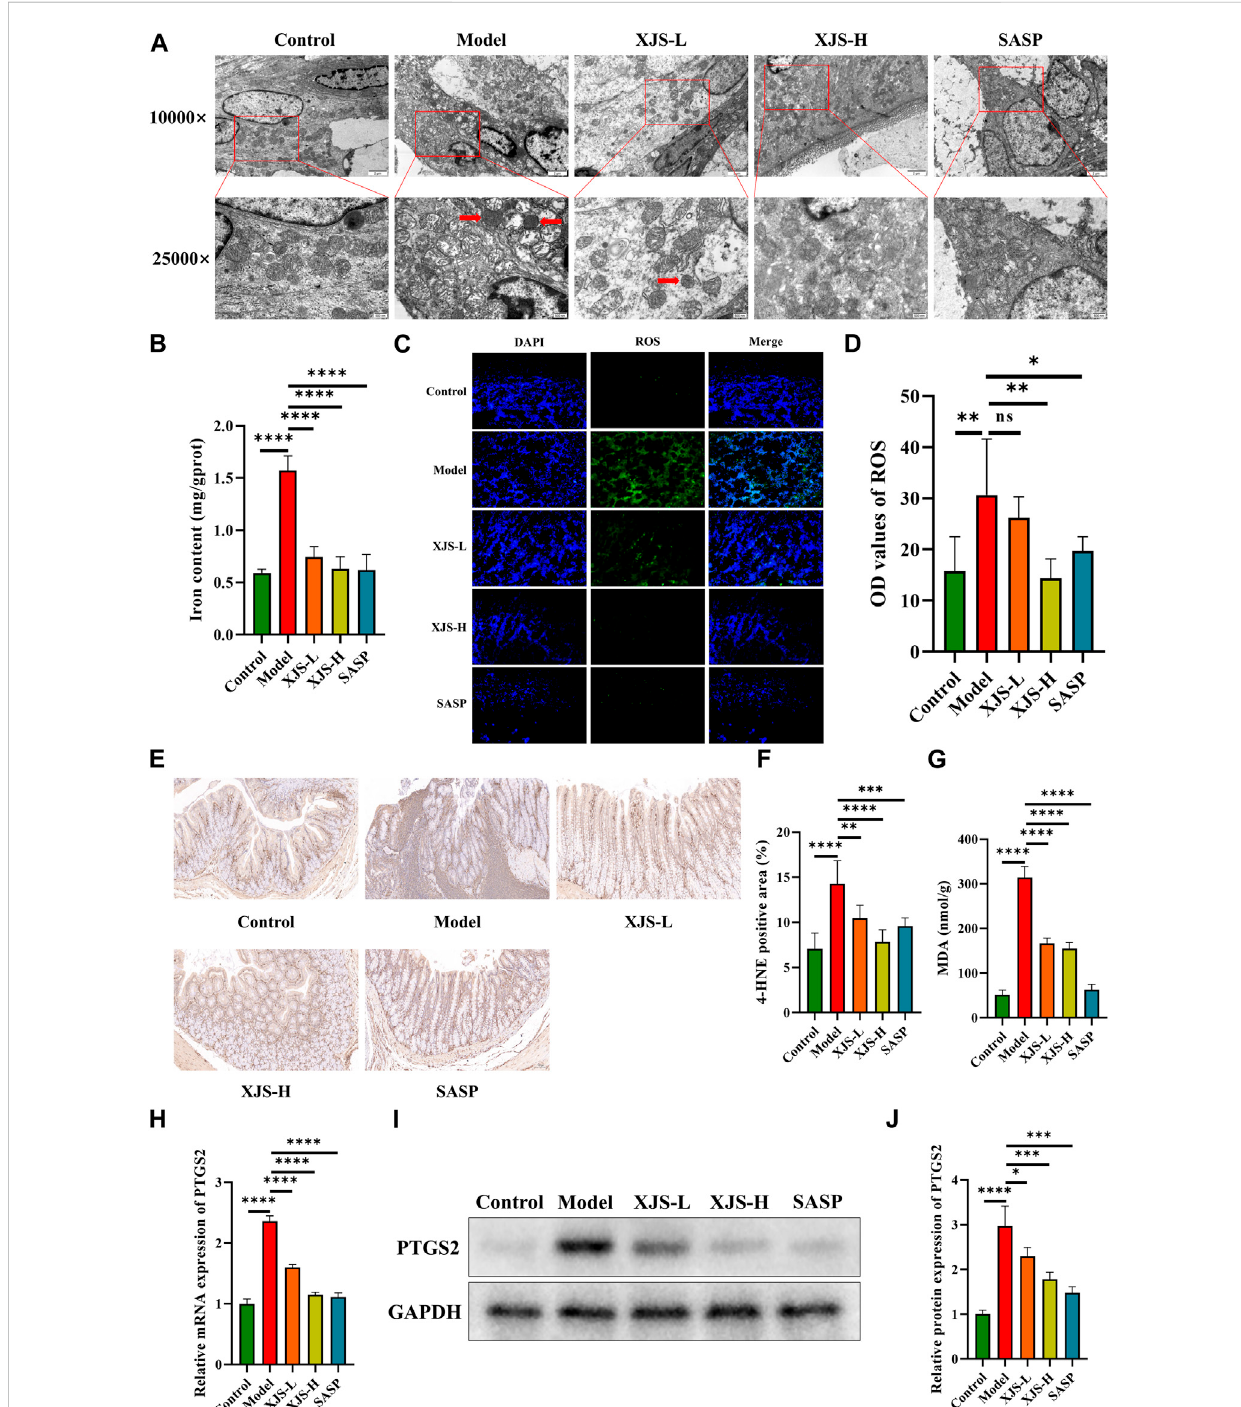
FIGURE 4 XJSinhibitedferroptosisinintestinalepithelialcells. (A) ShrunkenmitochondriacapturedbyTEM(redarrows)( n =5). (B) Ironlevels( n =6). (C,D) ROS levels detected by fl uorescent probe (original magni fi cation, ×200; n = 6). (E, F) The expressions of 4-HNE examined by immunohistochemical staining ( n =6). (G) MDAlevels( n =3). (H) ThemRNAexpressionlevelsofPTGS2( n =6). (I,J) TheproteinexpressionsofPTGS2( n =3).* p < 0.05,** p < 0.01,*** p < 0.001, **** p < 0.0001, ns = no signi fi